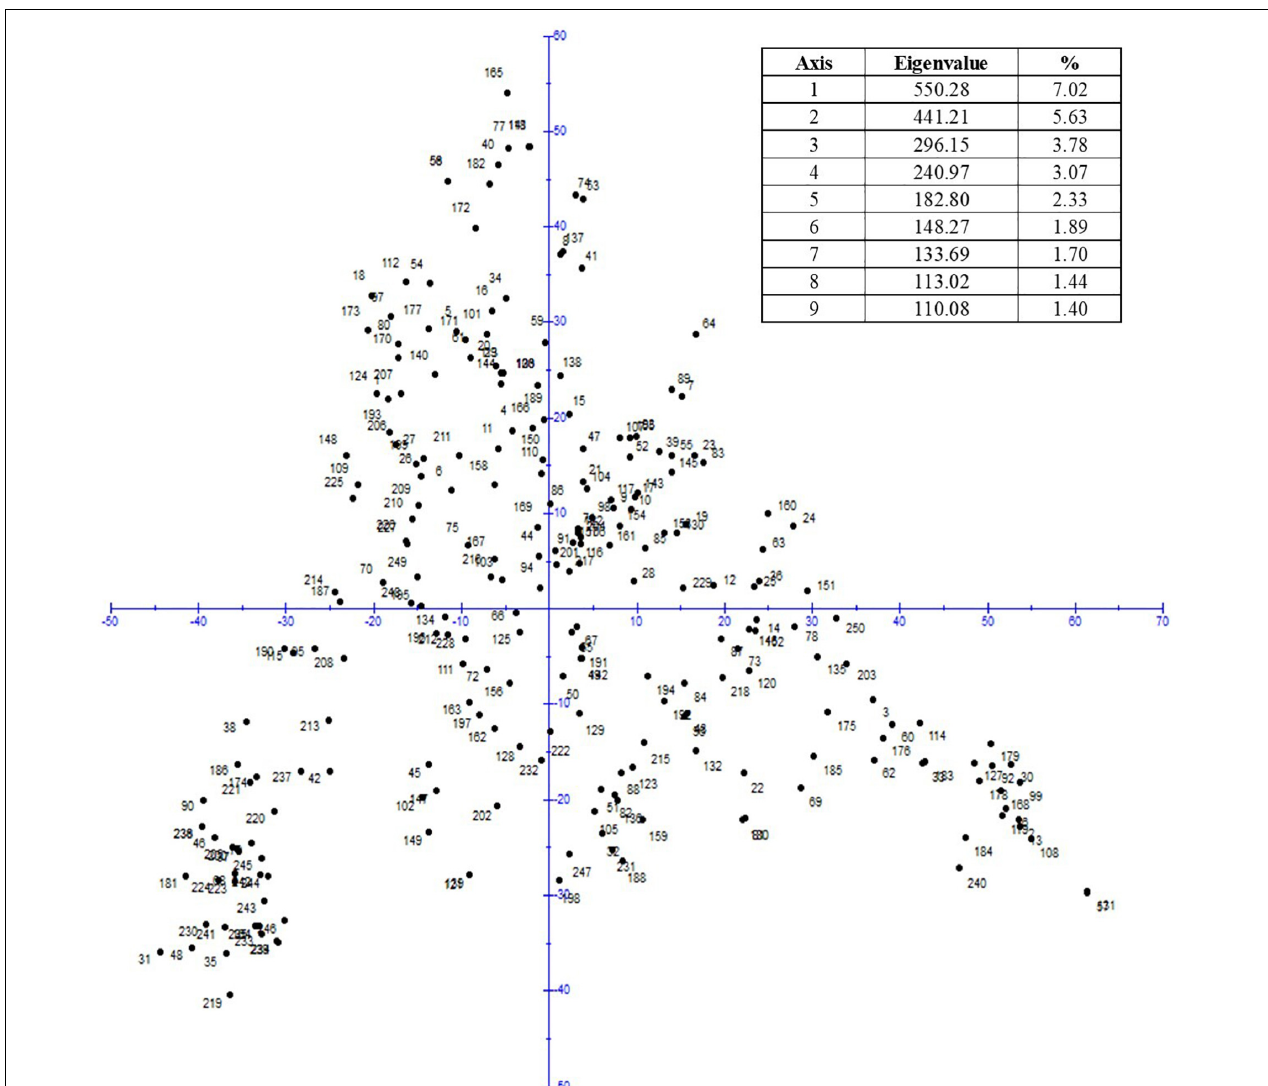
FIGURE 5 | Principal component